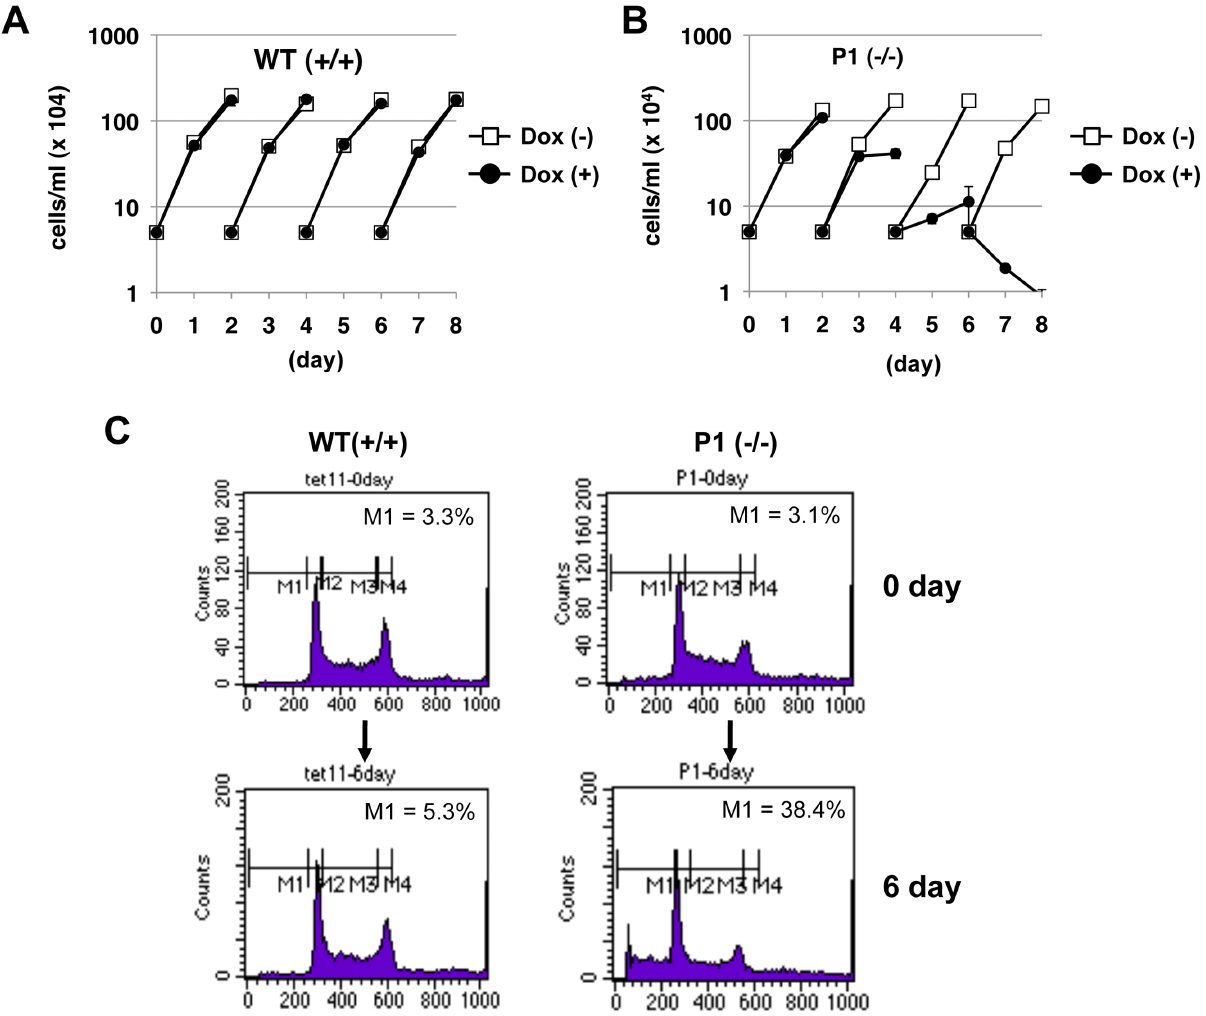
Figure 2. Ssu72 is essential for cell proliferation and viability in DT40 cells. (A, B) Growth curve of DT40 wild-type (WT) and conditional mutant [P1 ( 2 / 2 )] DT40 cells. WT (A) or P1 ( 2 / 2 ) (B) cells were seeded in triplicate in 12-well plates (5 6 10 3 cells/well) in media with or without doxycycline (Dox), and split every 2 days. Concentrations of live cells were determined by Giemsa staining and counted at the indicated time points. Cell density is shown on a logarithmic scale. (C) WT cells (left) or P1 ( 2 / 2 ) cells (right) treated with Dox for 6 days (lower) or untreated (upper) were subjected to FACS analysis after staining with propidium iodide. Gates M1, M2, M3, and M4, delimited by the vertical bars above the FACS traces, indicate the cell-cycle distributions of the sub-G1, G0/G1, S and G2 populations, respectively.